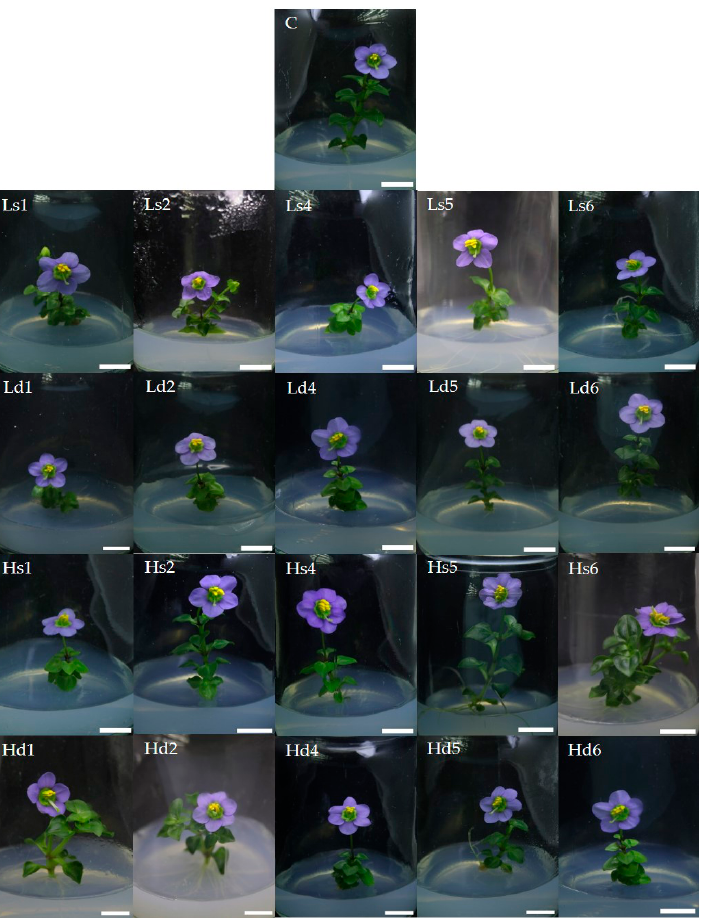
Plants 2021 , 10 , 2671 7 of 12 Values are means ± SD; means followed by the same letters within a column are not significantly different ( p < 0.05) according to Duncan’s multiple range test (DMRT).